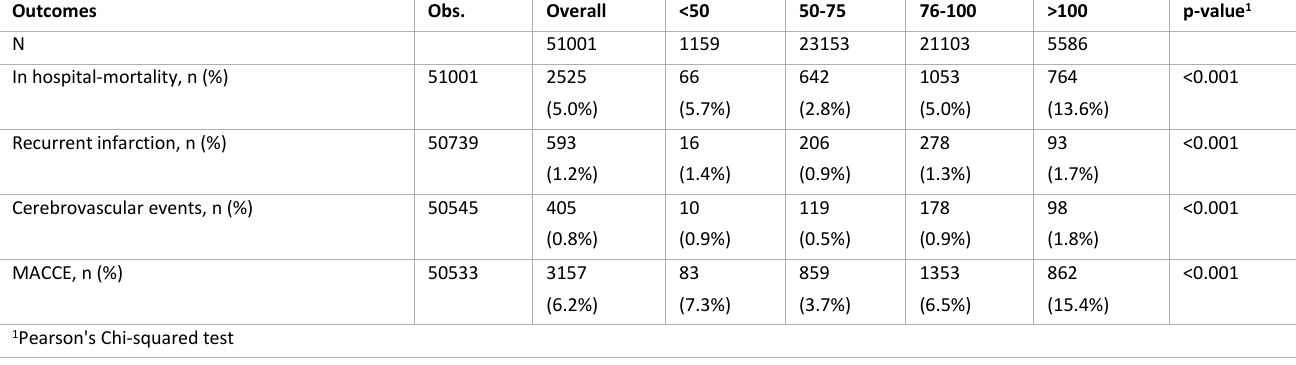
Table 1. In hospital outcomes. Crude outcomes of patients enrolled in the study, stratified according to HR admission. Number of non-missing observations reported in column Obs. Outcomes